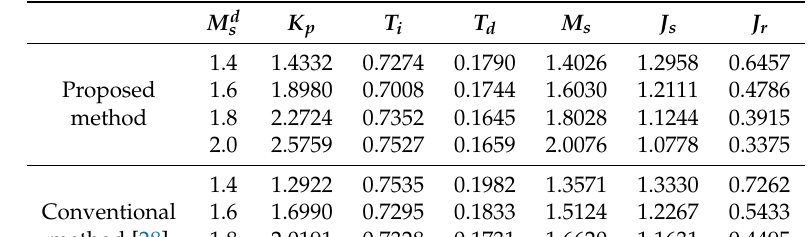
Table 9. Proportional-integral-derivative parameters, M s , and SAE values in the regulator design using Equation (46) and (48), respectively.